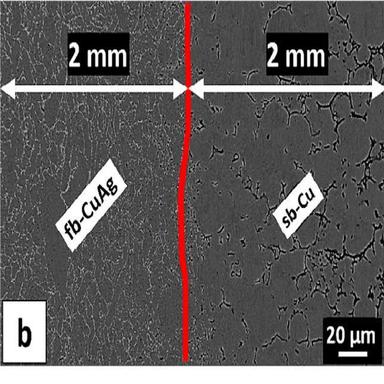
Interfaces of the (b) sub and middle layer, (a) middle and upper layer and (c) sub, middle and upper layer in same structure of FGM1.